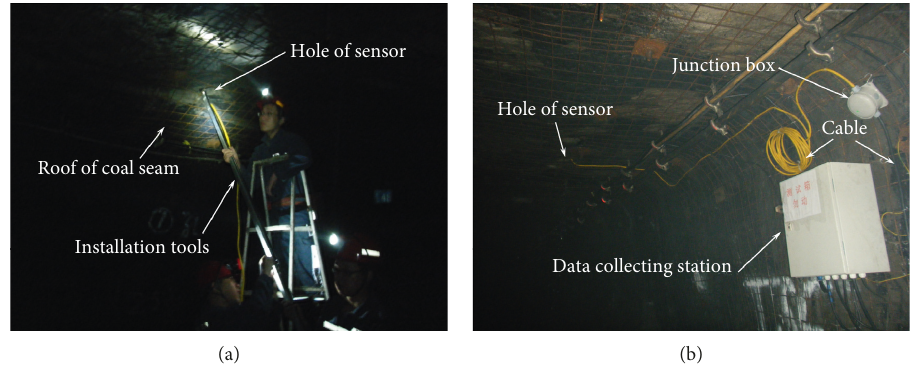
Figure 1: Field installation of the IMS monitoring system: (a) IMS sensor; (b) IMS system.